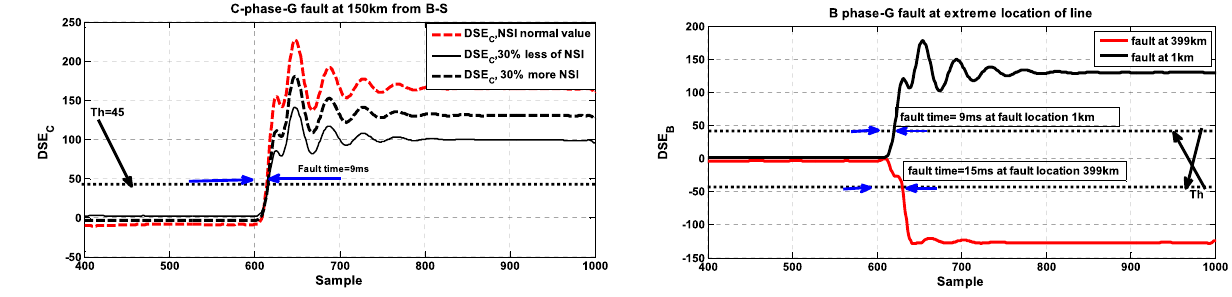
Fig. 7 B phase-G fault, 399 km and 1 km from B-S with phase